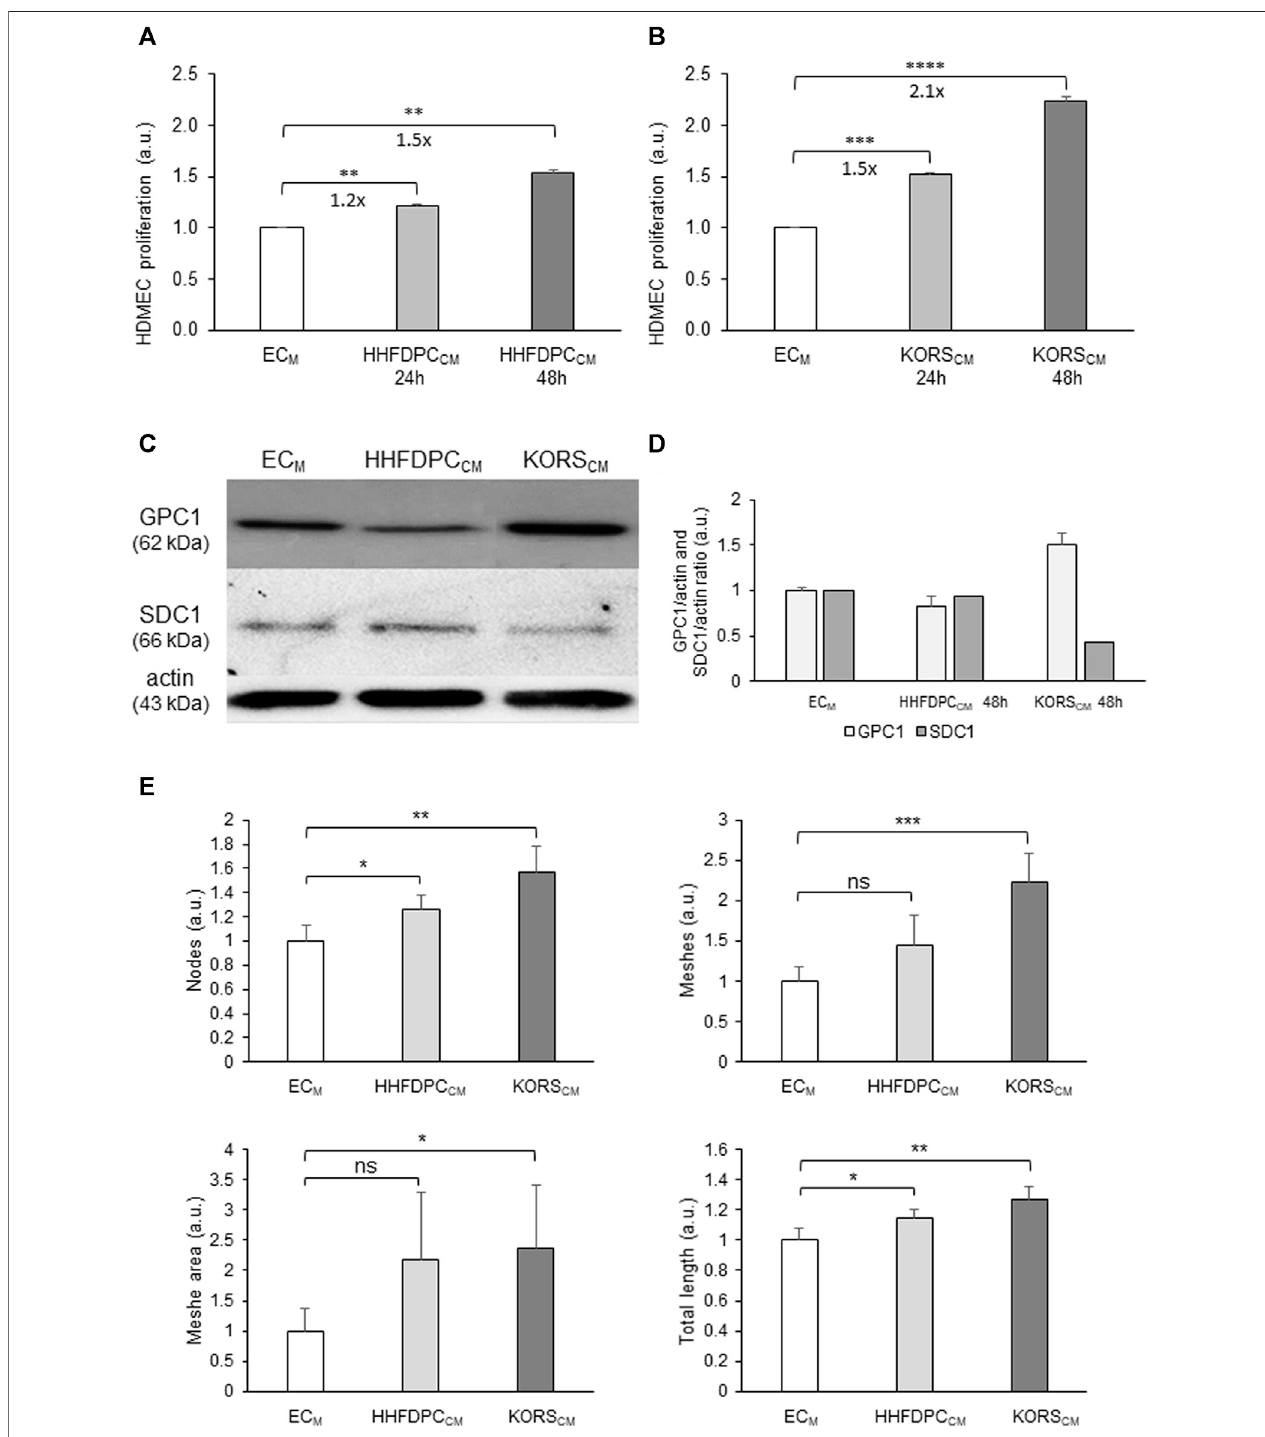
FIGURE 4 | Effect of HHFDPC CM and KORS CM on HDMEC behaviors. (A,B) HDMEC proliferation was measured by colorimetric assay using WST-1 dye in presenceofEC M basalcellculturemediumorHHFDPC CM (A) ,andinpresenceofEC M orKORS CM (B) for24or48 handexpressedasthemean ± SEM, n (cid:2) 8replicates and three independent experiments (C,D) . Protein expression and quanti fi cation of GPC1 and SDC1 in the HDMECs as determined by Western immunoblotting. The cells were incubated in HHFDPC CM or KORS CM for 48 h before the analysis. The results are expressed as the mean ± SD, n (cid:2) 2 for SDC1 and four independent experimentsforGPC1. (E) ComparisonoftheeffectsoftheHHFDPC CM andKORS CM (24 hofincubation)onHDMECpseudotubeformation.TheKORS CM hadthemost signi fi cant effect on HDMECs. Mean ± SD, n (cid:2) 3 replicates and two independent experiments.